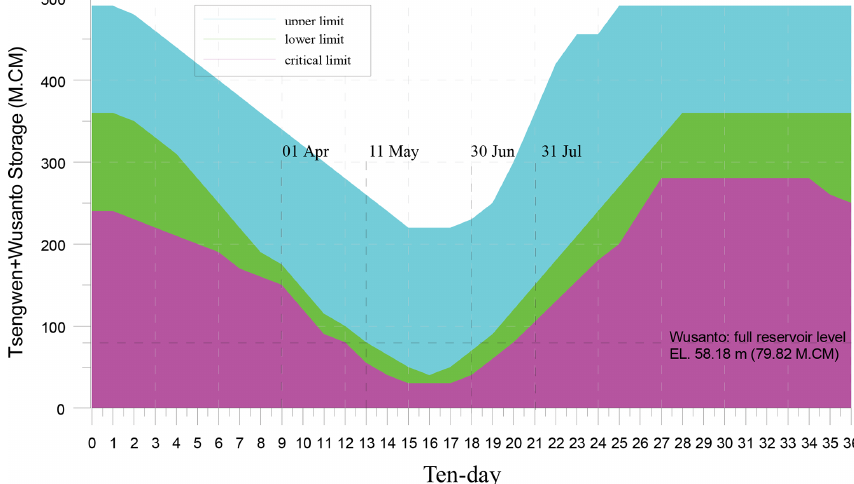
Figure 3. Joint operating rule curves of the Tsengwen and Wushanto reservoirs.